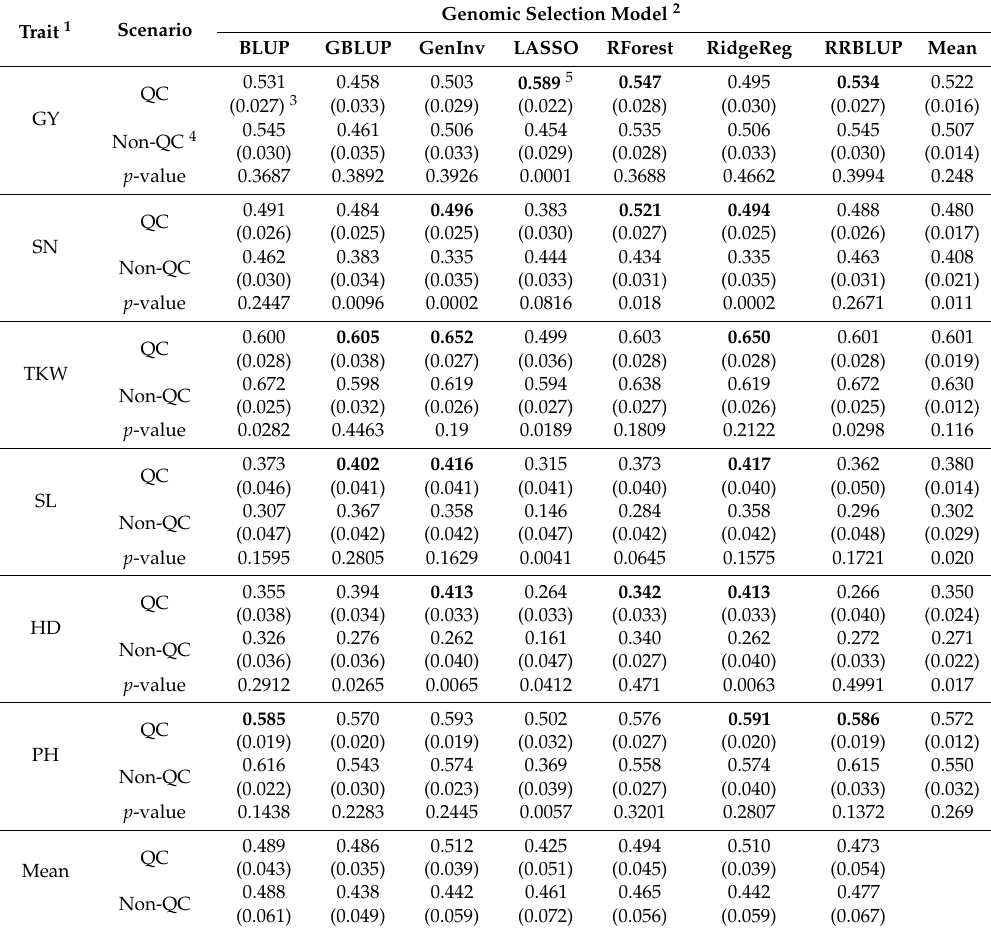
Table 3. Prediction accuracy with marker quality control (QC) or non-QC for six traits and seven genomic selection (GS) models. The QC to keep markers with missing rate levels < 40% and minor allele frequency (MAF) > 5% was used as an